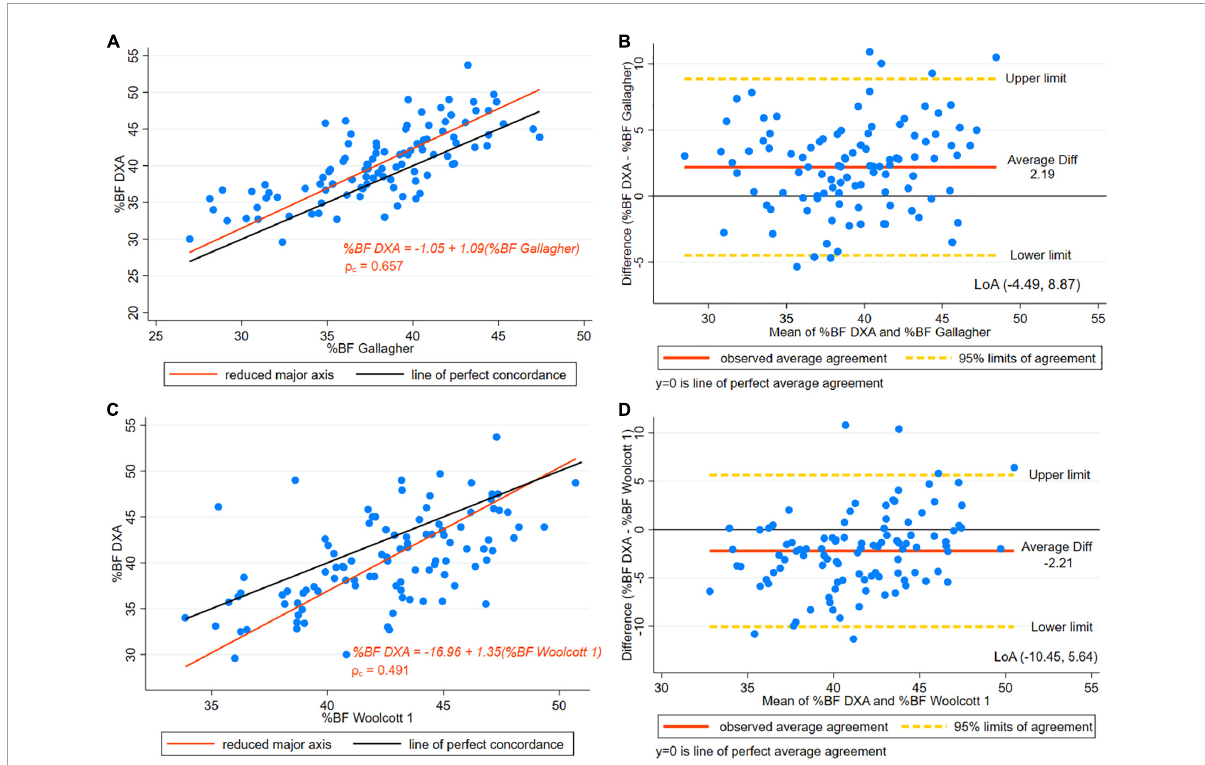
FIGURE3 (A) Concordance plot of body fat percentage (BF%) estimated by DXA and Gallagher’s equation. Pearson’s correlation coefficient (r) and Lin’s concordance correlation coefficient ( ρ c ) for women with height > 145 cm. (B) The Bland-Altman plot is presented along with the Limits of Agreement (LoA) for BF% estimated by DXA and Gallagher’s for women with height > 145 cm. (C) Concordance plot for BF% estimated by DXA and Height/Waist ratio Woolcott’s equation (Woolcott equation 1) in women with height > 145 cm. (D) The Bland-Altman plot is presented along with the LoA for BF% estimated by DXA and height/waist ratio Woolcott’s equation (Woolcott equation 1) in women with height > 145